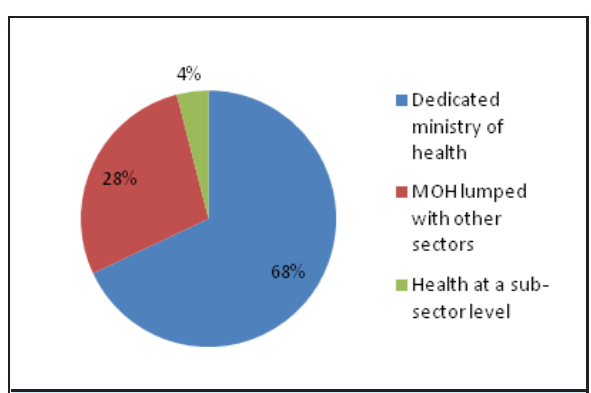
Figure 5. Federal system v/s governance structure. The analysis so far involved the countries and their population irrespective of the governance system.